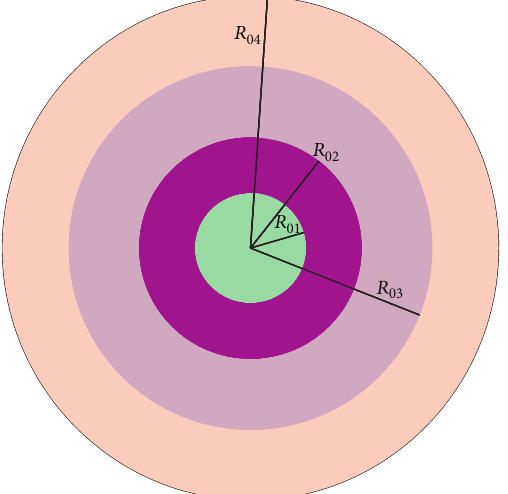
Figure 1: Different-radius circular wells constructed by shift opera- tors for 𝑚 = 0 case.